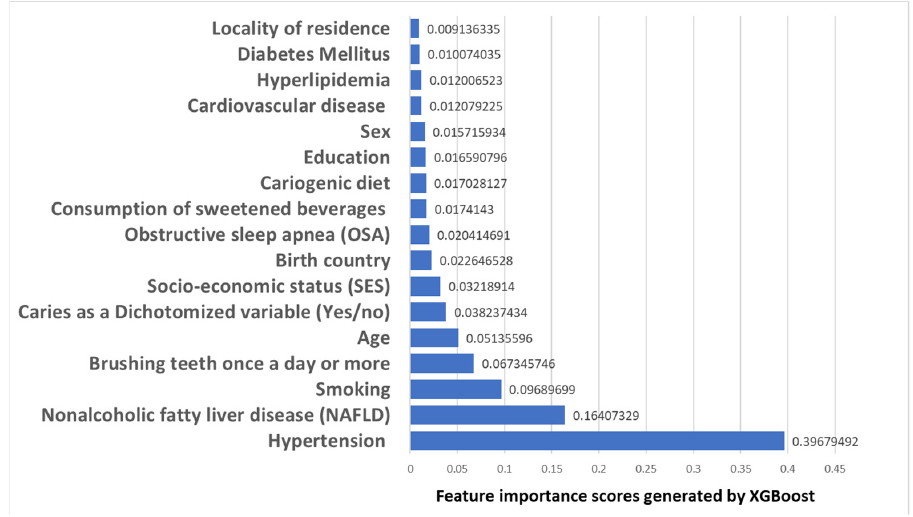
Figure 3. Clinical Features Importance ranking chart based on XGBoost Machine Learning algorithm for obesity (BMI ≤ 30 kg/m 2 ) set as target variable. Values are the importance rankings of the features ranks from highest (hypertension) to lowest (locality of residence), with caries as a dichotomized variable ranked sixth in features importance.